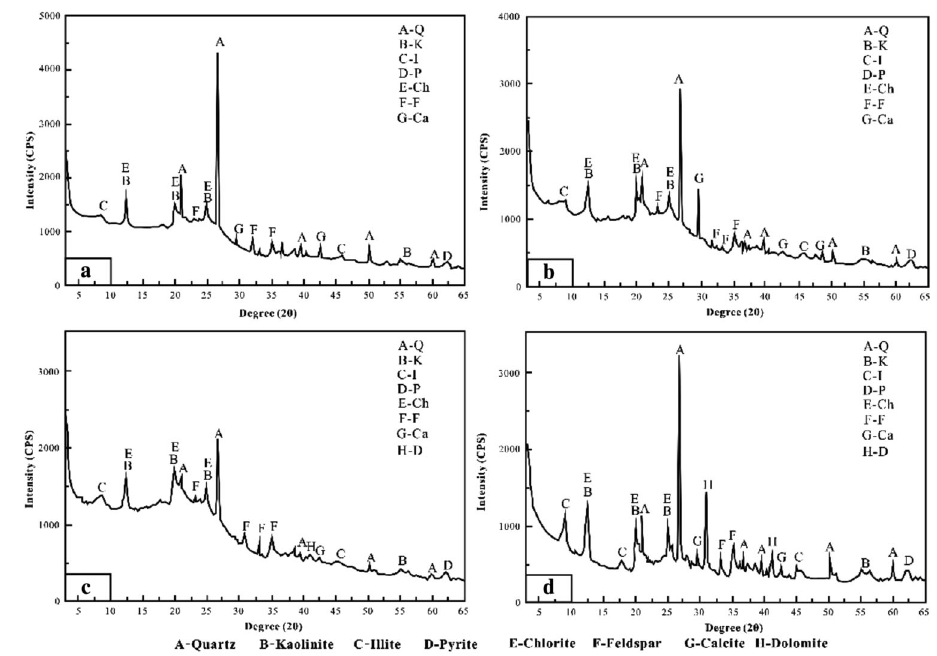
Fig. 4 XRD analysis on samples from Xishanyao Formation, Hanshuiquan district, Santanghu Coalfield,